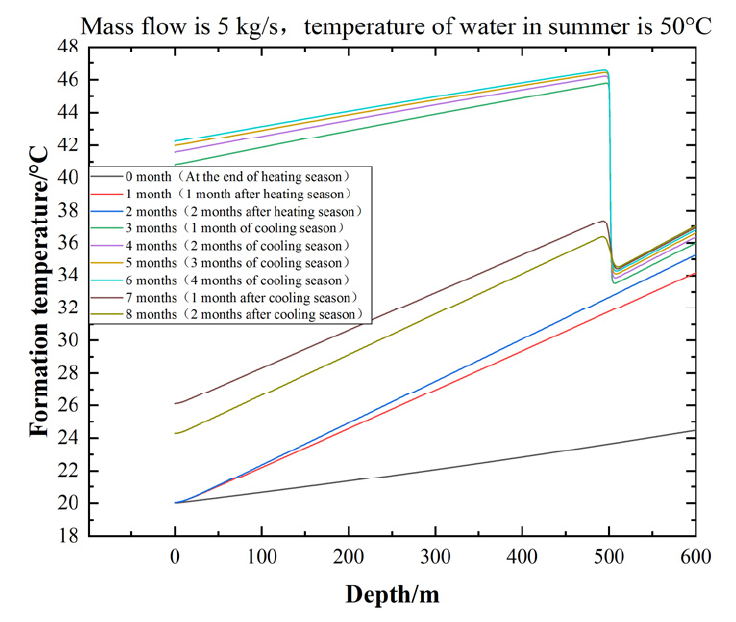
Figure 9. Temperature of formation near the well at depths from 0 to 600 m.